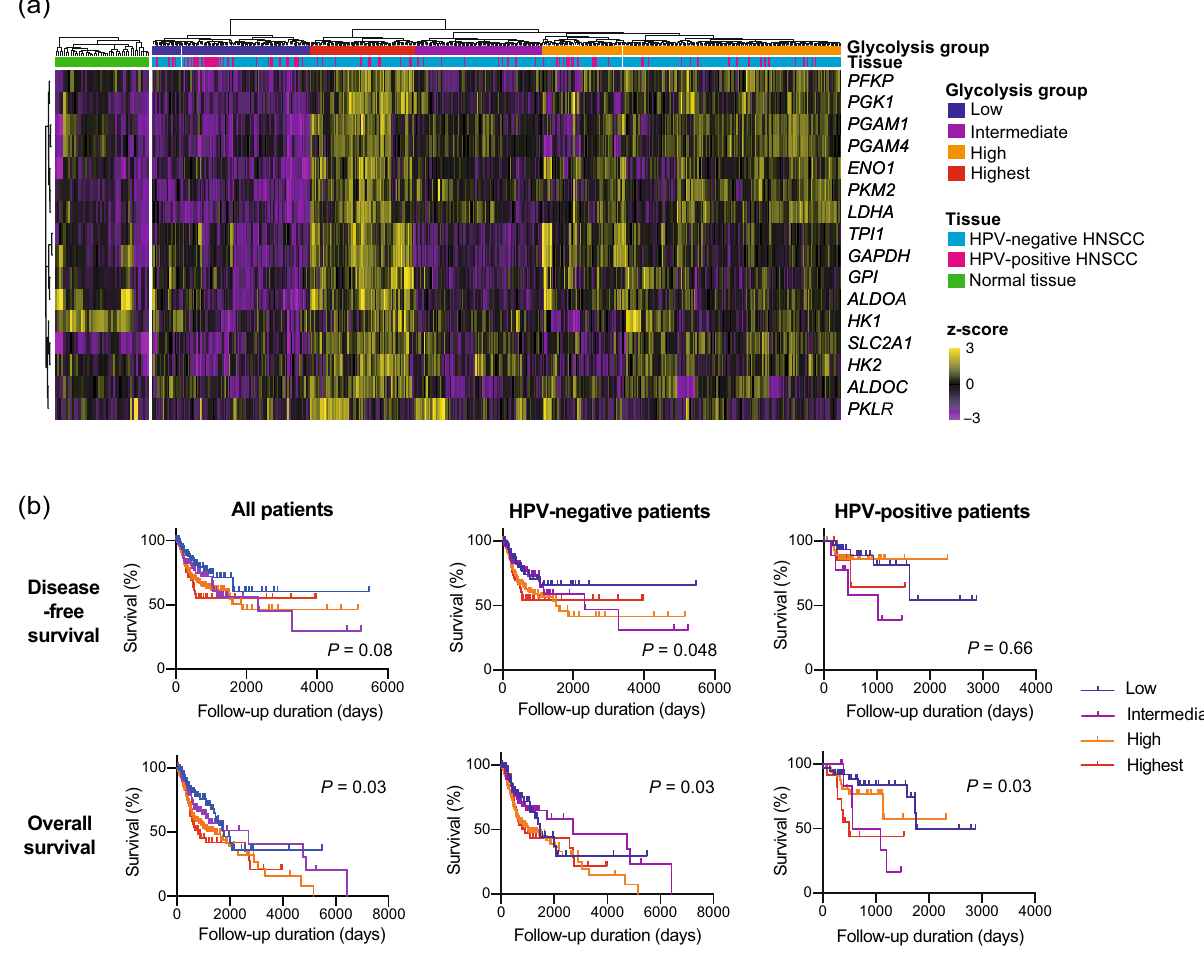
Figure 1. Glycolytic activity positively correlated with unfavorable prognosis. ( a , b ) mRNA expression data of 16 glycolysis-related genes and clinical information were obtained from TCGA database. ( a ) Heat map of glycolysis-related gene expression in 44 normal tissues and 520 patients with HNSCC. All patients with HNSCC underwent non-supervised hierarchical clustering based on the z-scores of log 10 -transformed expressions. ( b ) Kaplan–Meier survival curves based on glycolysis groups. Disease-free survival was evaluated in all patients (n = 429), HPV-negative patients (n = 348), and HPV-positive patients (n = 81). Overall survival was evaluated in all patients (n = 495), HPV-negative patients (n = 403), and HPV-positive patients (n = 92). TCGA, The Cancer Genome Atlas; HNSCC, head and neck squamous cell carcinoma; HPV, human